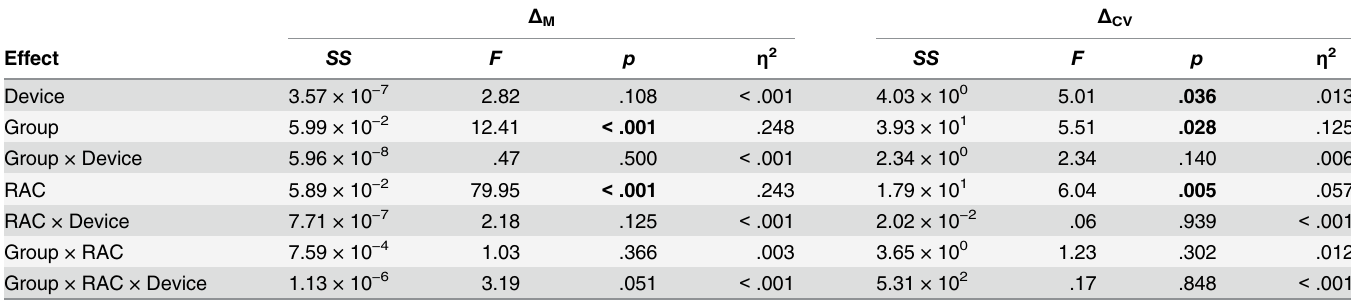
Table 3. Statistics associated with the Group × RAC × Device ANOVA for step time outcome measures.